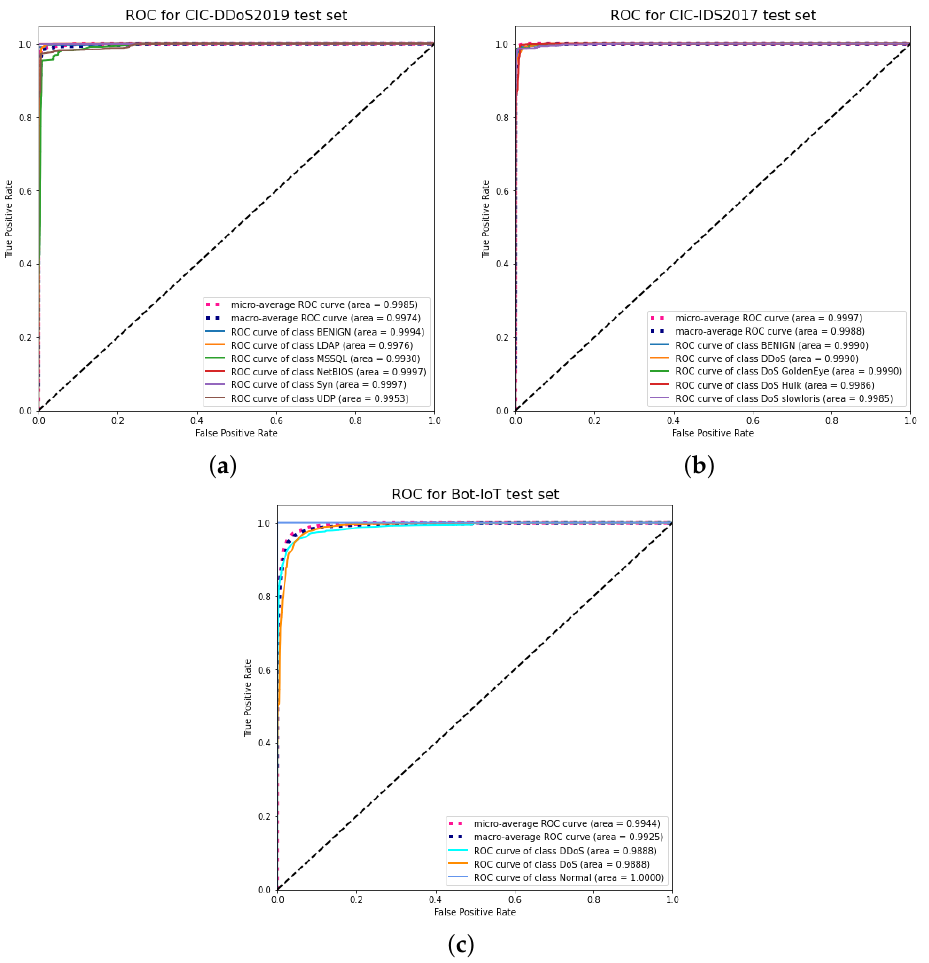
Figure 6. ROC curve results on three test sets. ( a ) CICDDoS2019; ( b ) CIC-IDS2017; ( c )